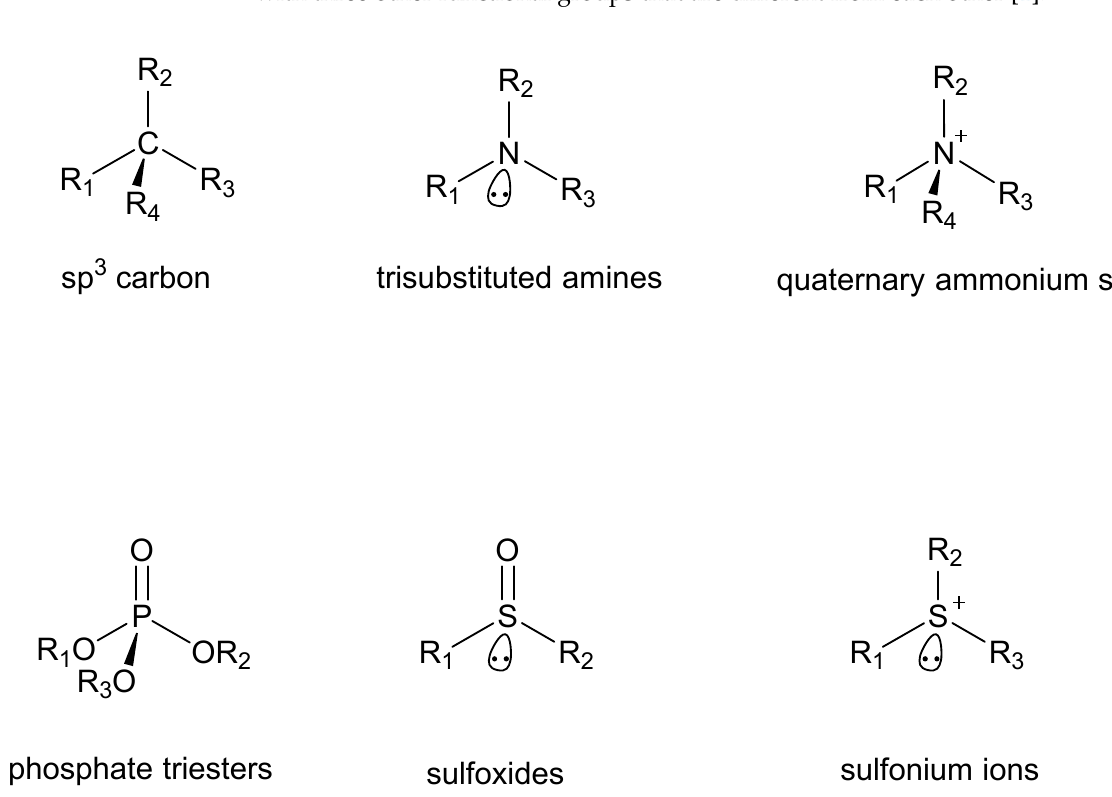
Figure 1. Stereogenic centers on different (C, N, P, and S) atoms tetrahedral configuration.